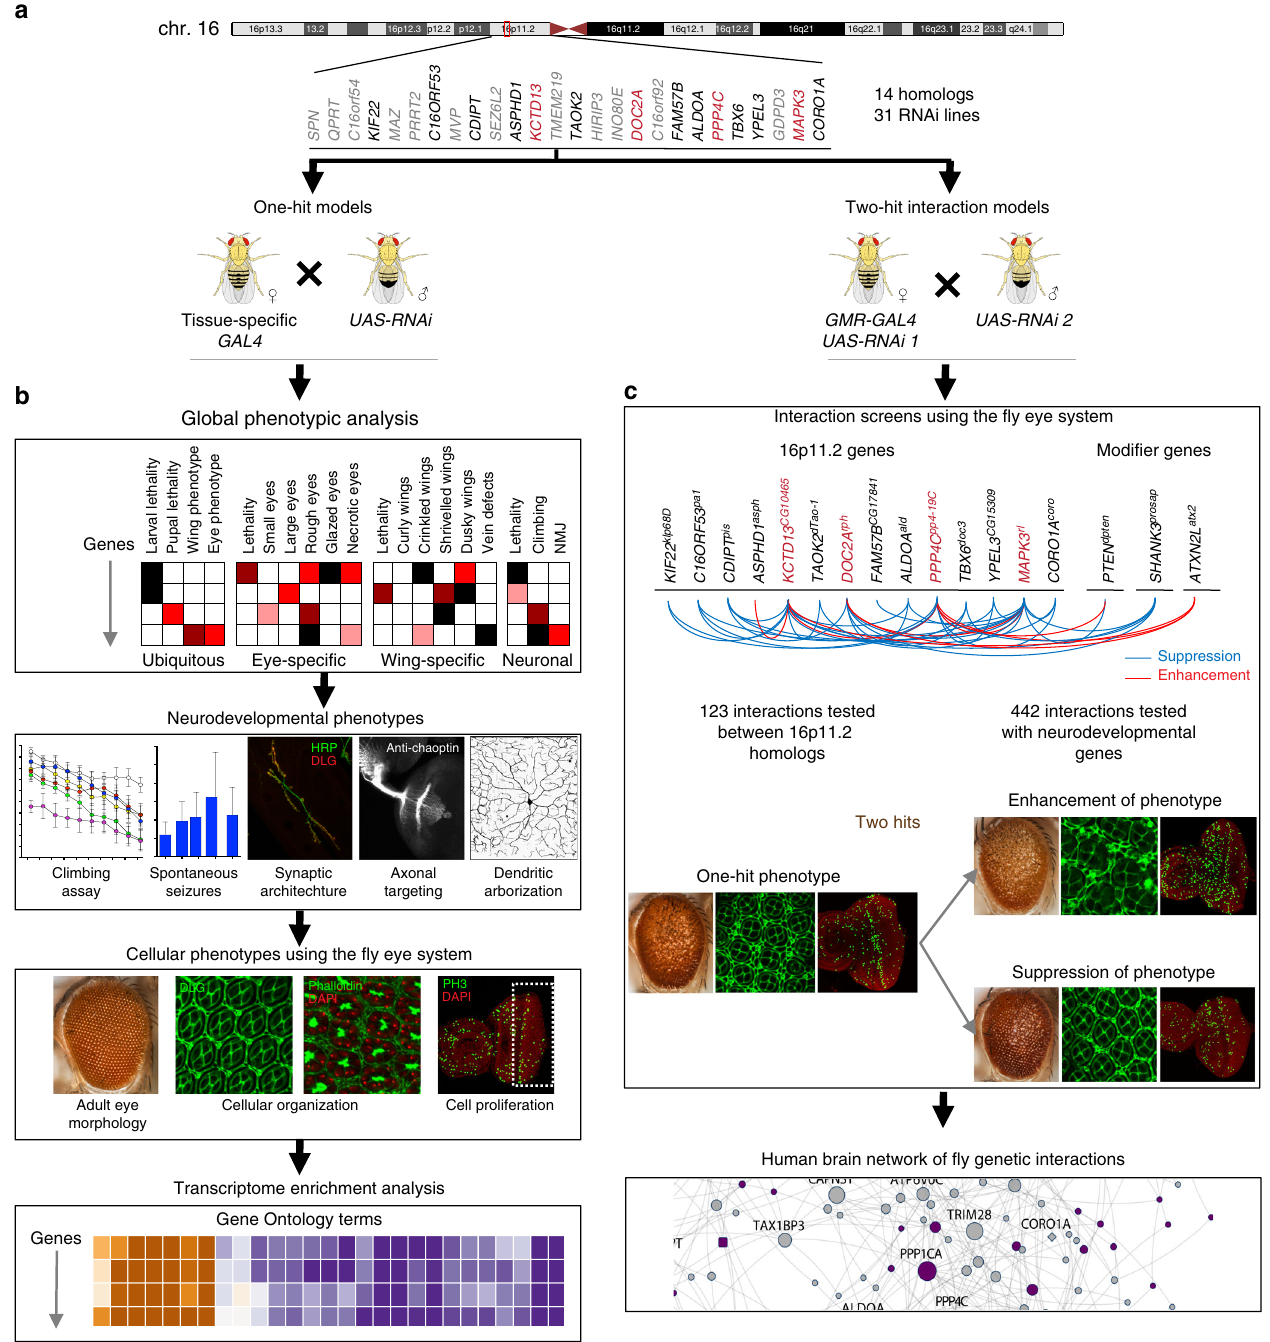
Fig. 1 Strategy for identifying neurodevelopmental phenotypes in 16p11.2 fl y homologs. a We identi fi ed 14 homologs of 16p11.2 deletion genes in Drosophila melanogaster , and b evaluated global, neurodevelopmental, and cellular phenotypes. We also performed transcriptome sequencing and assessed changes in expression of biologically signi fi cant genes. c Next, we identi fi ed modi fi ers of the one-hit eye phenotype for select homologs using two-hit interaction models. A subset of these interactions were further assessed for cellular phenotypes in the two-hit knockdown eyes. We incorporated all fl y interactions into a human brain-speci fi c genetic interaction